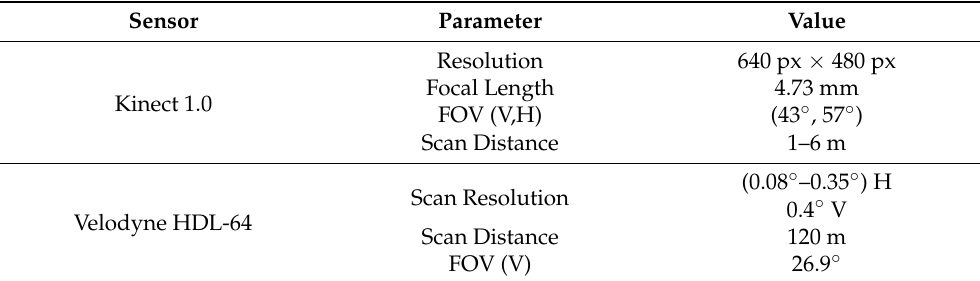
Table 2. Kinect and LIDAR parameters in the numerical simulation